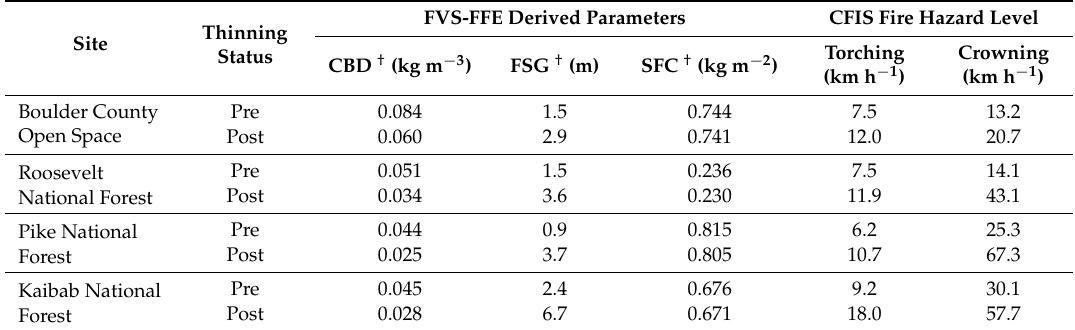
Table 2. Immediate pre- and post-treatment FVS-FFE derived fuel parameters and CFIS fire hazard levels for the four